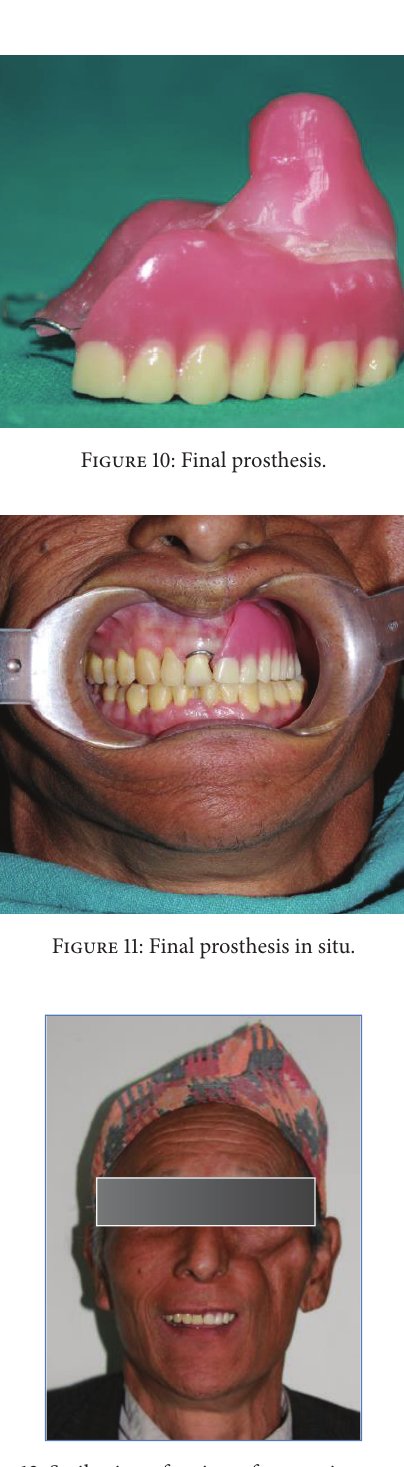
Figure 12: Smile view of patient after wearing